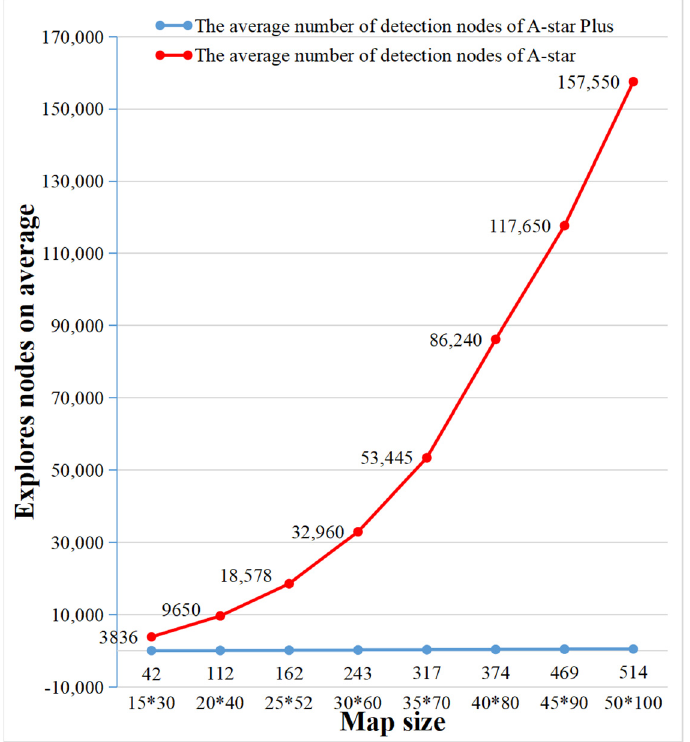
Figure 12. Comparison of explore node between A-star algorithm and A-star Plus algorithm.